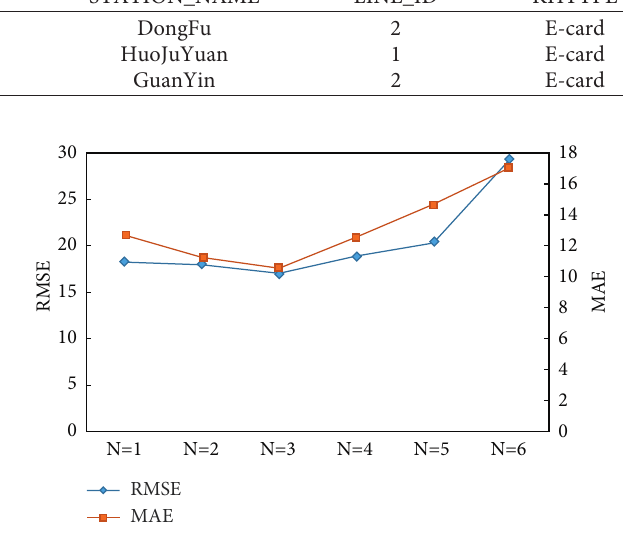
Figure 6: Performance with different number of GCN layer.